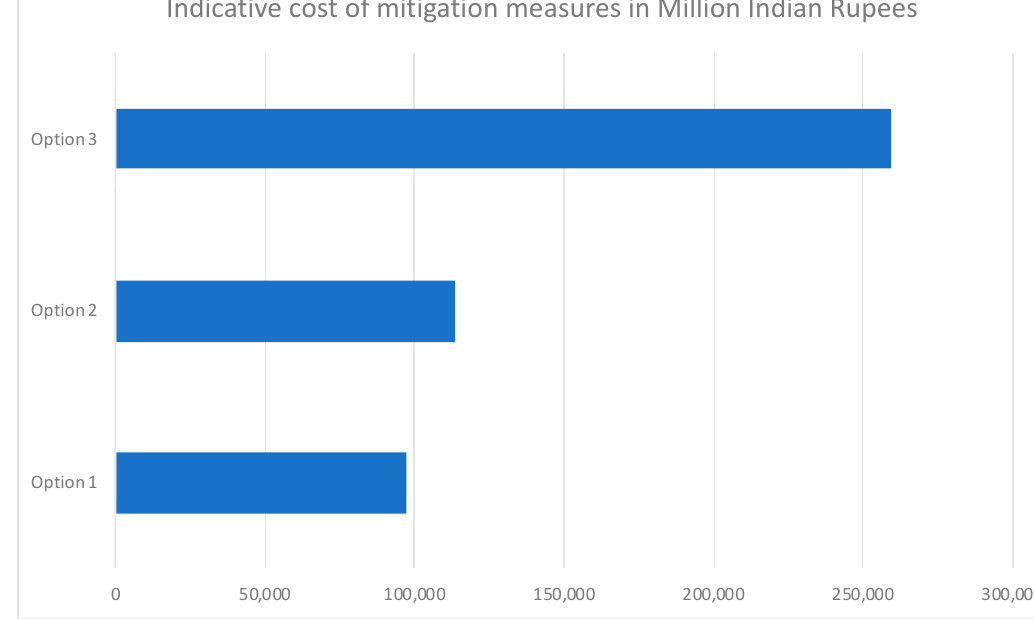
Figure 5. Tentative cost of strengthening resilience in the power sector (USD 1 USD = INR 75) Source: